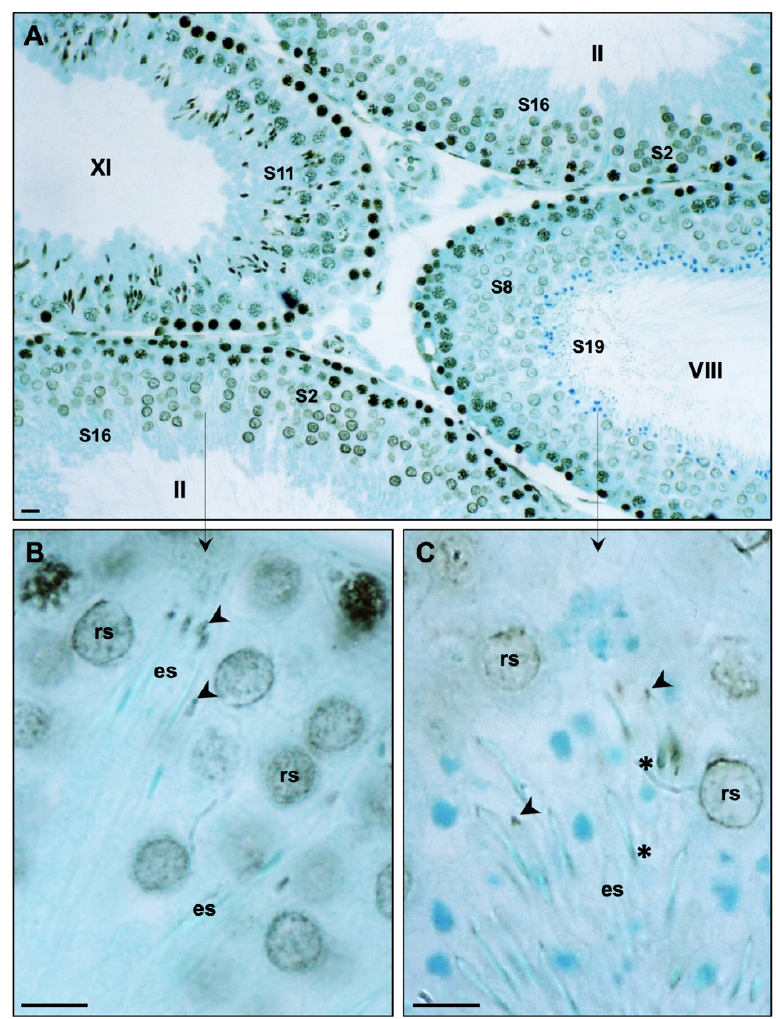
Figure 7. Light micrographs of immunoperoxidase-labeled sections, counterstained with methylene blue, through rat seminiferous tubules of stages II, VIII, and XI probed with an affinity-purified anti-H3 antibody: ( A ) Immunoreactivity of varying intensity is found in the nuclei of most germ cells, except for elongated spermatids (es) found in stages II and VIII. Bar = 20 μ m ( B , C ). Arrows from stages II and VIII in ( A ) point to a similar region (not identical) of the seminiferous epithelium, magnified several-fold, where elongated spermatids reside. Note that the tips or perforatoria of spermatid heads are immunoreactive (arrowheads). ( C ) The triangular rod-like structure of the perforatorium (arrowheads) is made evident by the immunoperoxidase labeling. In some planes of the section, immunoreactivity in the caudal part of the elongated head or post-acrosomal sheath region is evident (asterisk). Bar = 5 μ m; rs, round spermatid; S2–S19, spermatid steps 2 to 19 of spermiogenesis. Anti-histone labeling of the post-acrosomal sheath can be seen more prominently in Figure S3C.